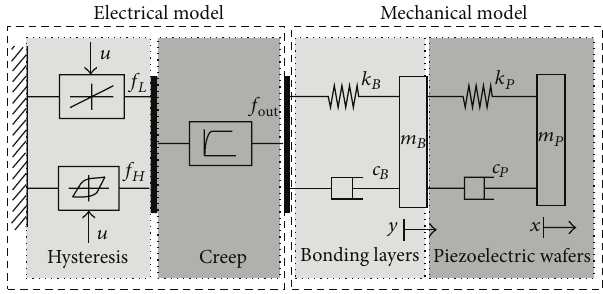
Figure 2: Modified comprehensive model for PSAs.